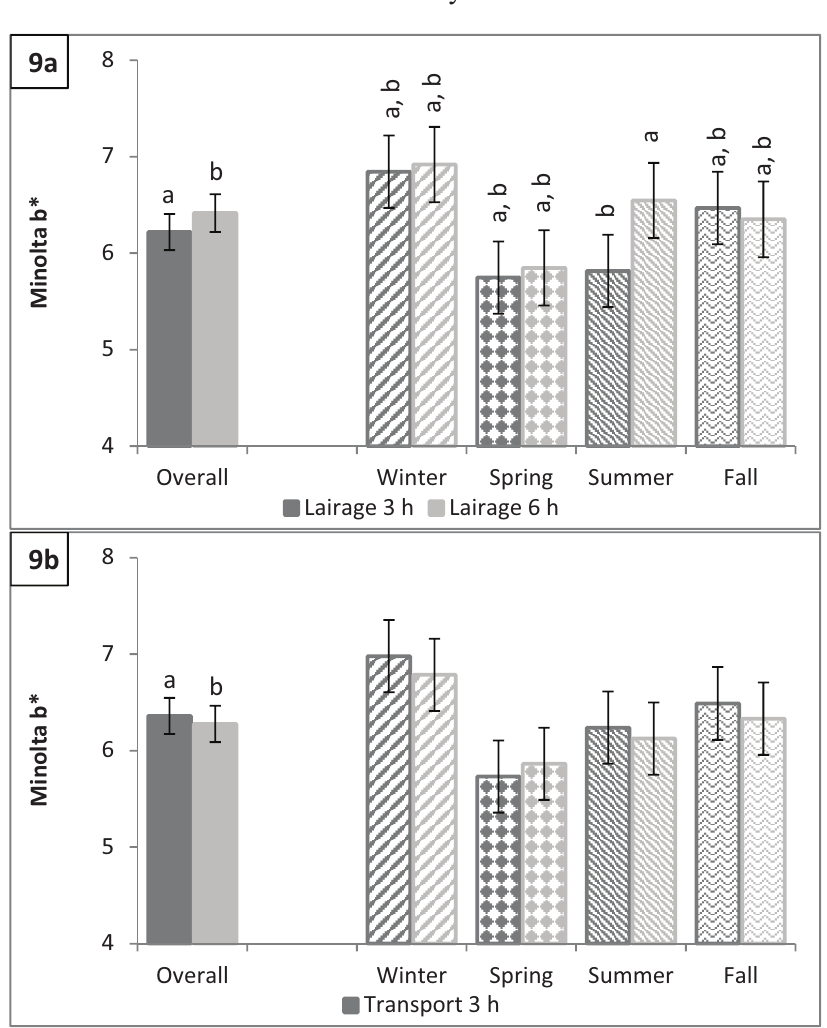
Figure 9. Minolta b* ( a ) by lairage duration (P < 0.0001) and by season × lairage duration (P < 0.0001) and ( b ) by transport duration (P = 0.03) and by season × transport duration (P = 0.009). Values with different letters differ by P < 0.05.